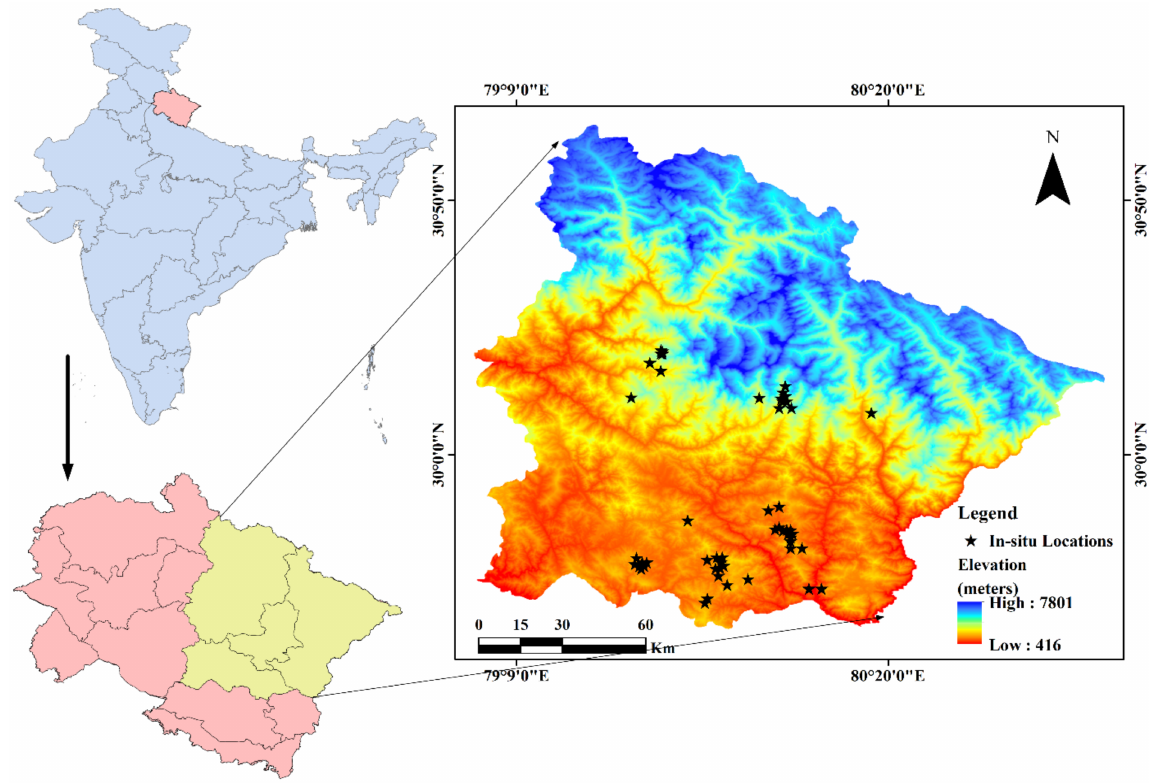
Figure 1. Location of the study area in the Western Himalayan